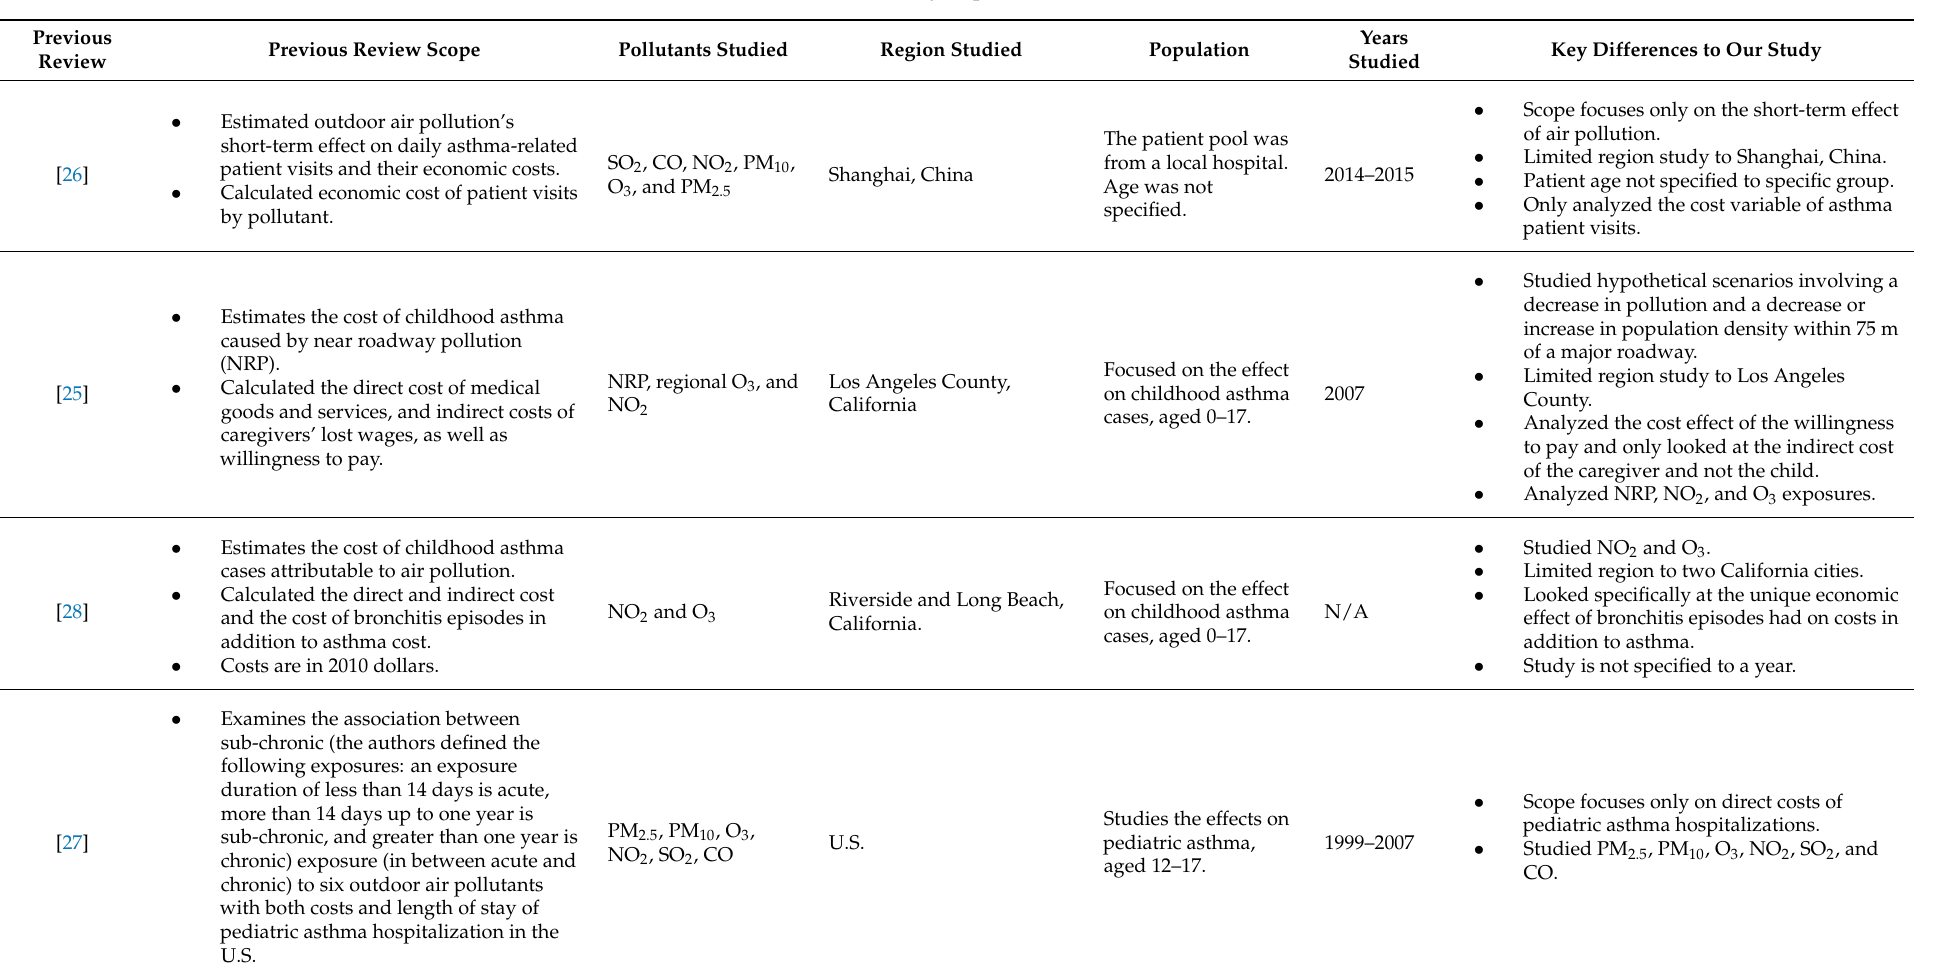
Table 1. Summary of previous